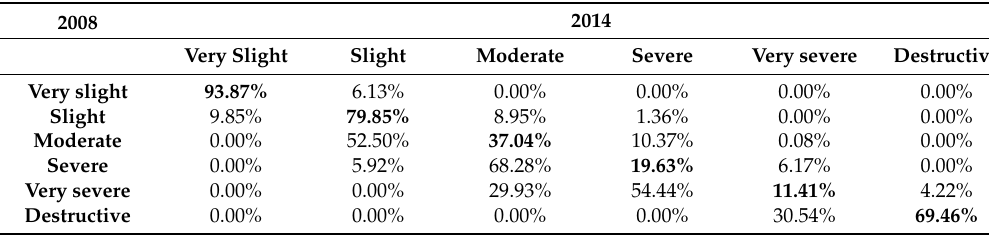
Table 5. The transition probability matrix of soil erosion intensity in the Wangjiagou agricultural watershed from 2008 to